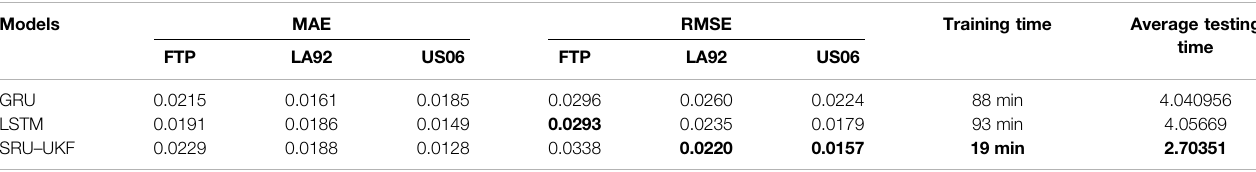
TABLE 5 | Comparison of SOC estimation against three drive cycles.